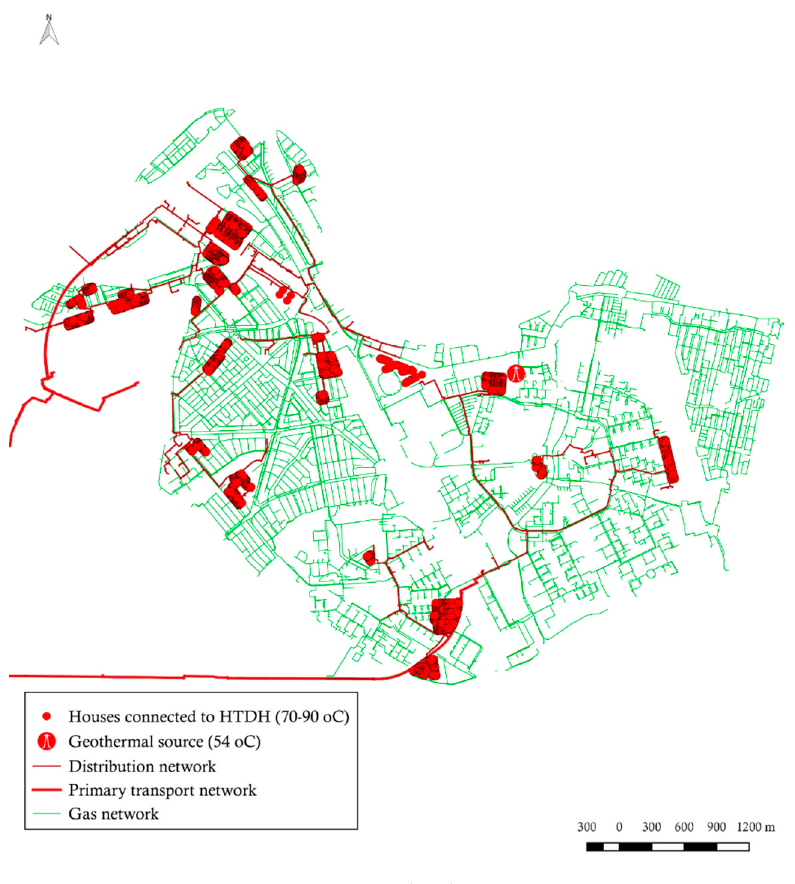
Figure 9. Centralised scenario. Figure 2 . Centralised scenario.